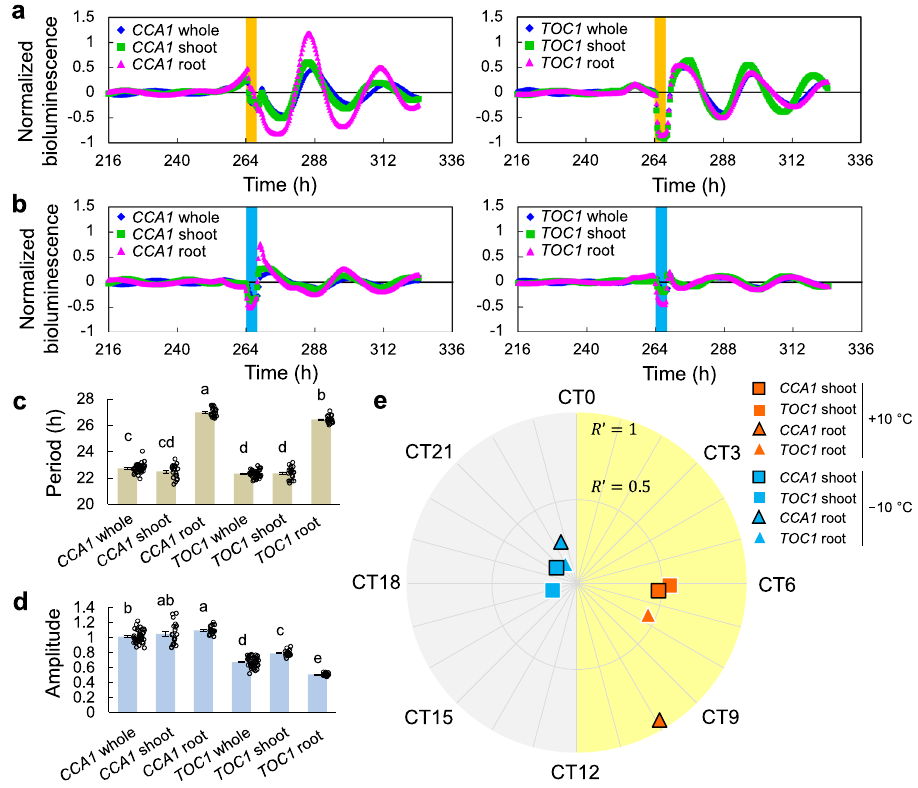
Fig. 4 Organ speci fi city in SR. a Reset of circadian rhythm against + 10 °C stimulus for 4 h ( n = 20 in whole plant and 10 in organs, mean ± standard error (SEM)). b Reset of circadian rhythm against − 10 °C stimulus for 4 h ( n = 20 in whole plant and 10 in organs, mean ± SEM). c Intrinsic periods ( n = 40 in whole plant and 20 in organs, mean ± SEM). d Amplitude at beginning of measurement ( n = 40 in whole plant and 20 in organs, mean ± SEM). In c and d , two values which have no common letter indicate signi fi cant differences (Tukey – Kramer test, p < 0.05). The circles indicate the individual data. e CT mapping of Θ ′ and R ′ . The graph represents the results as means ( n =